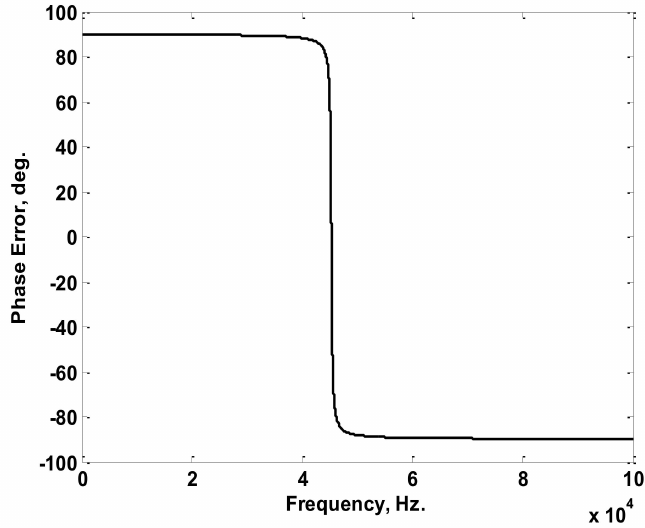
Figure 6. Difference in Phase Angles between the 1 A Injected Current and the Terminal Voltage versus Frequency Characteristics of the Simulated